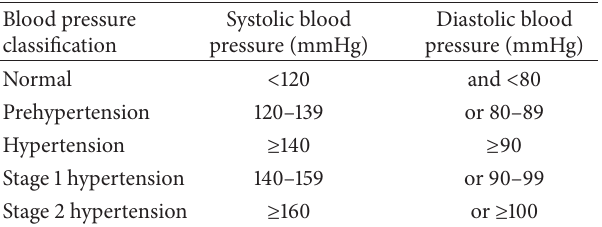
Table 1: Joint National Committee Classification of blood pressure for